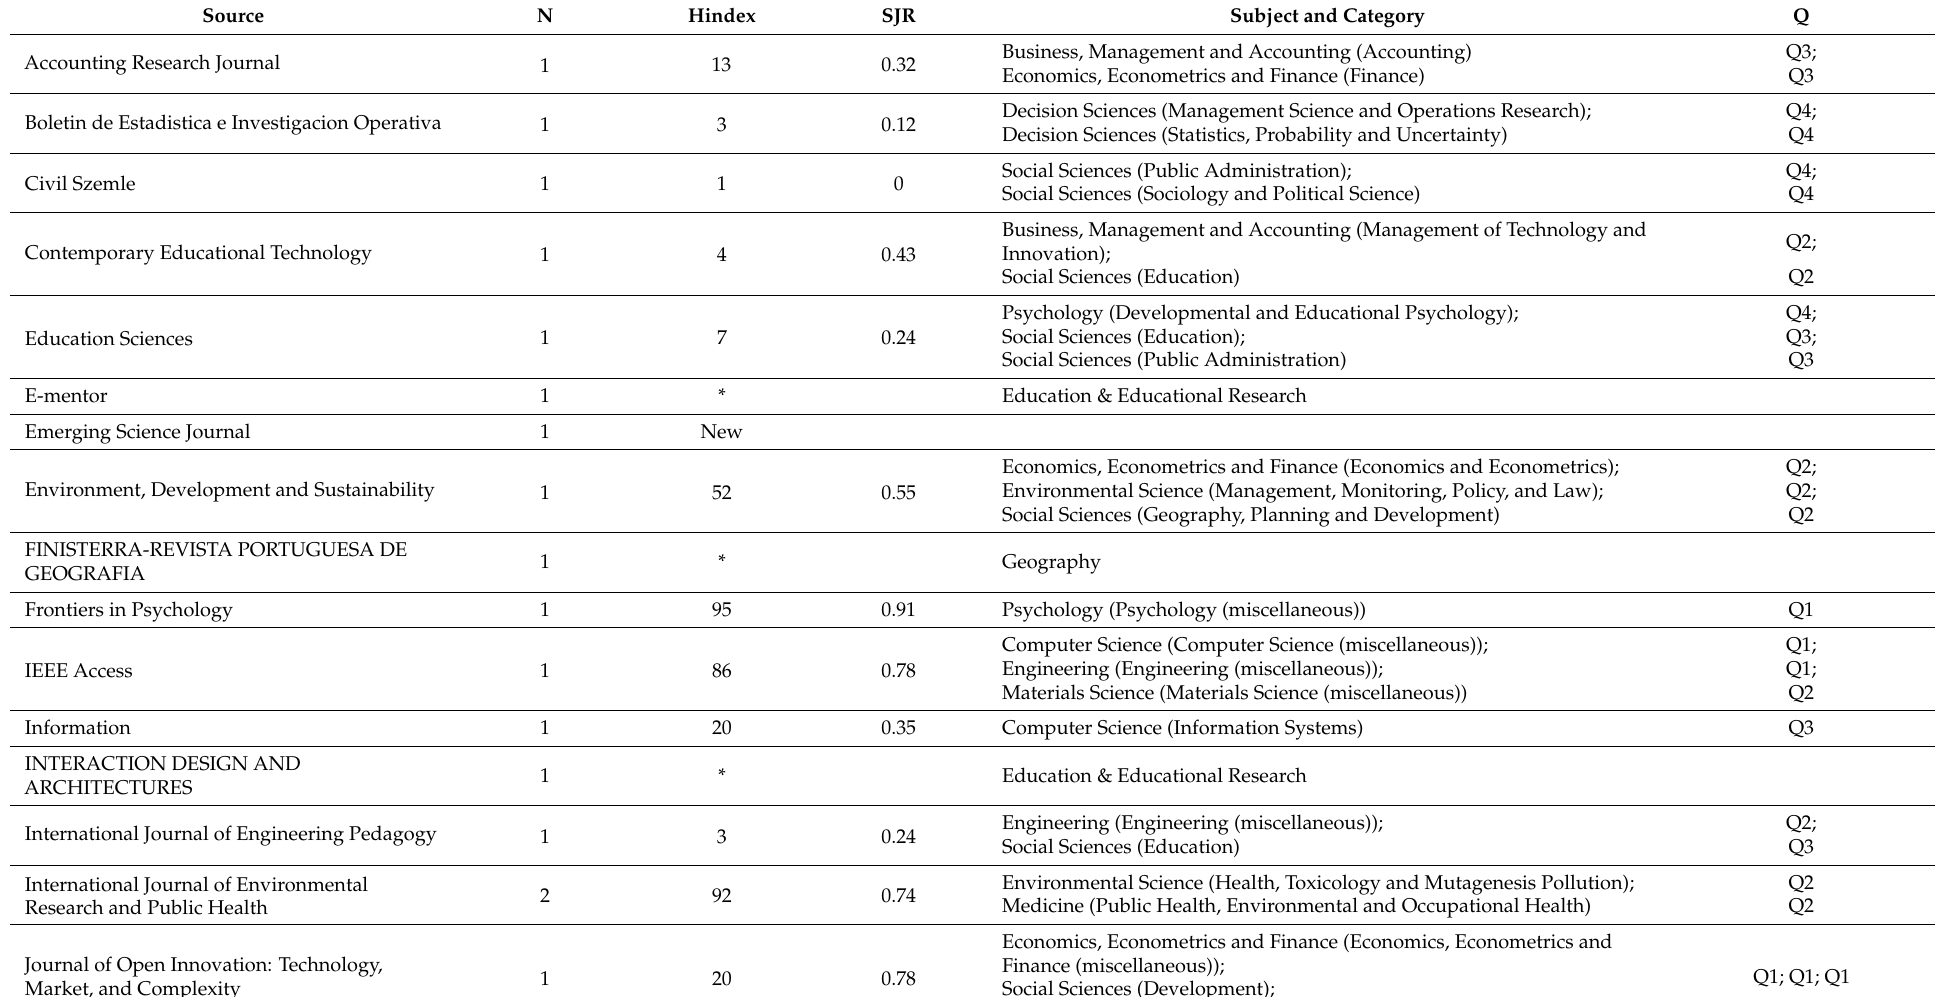
Table 2. Journal